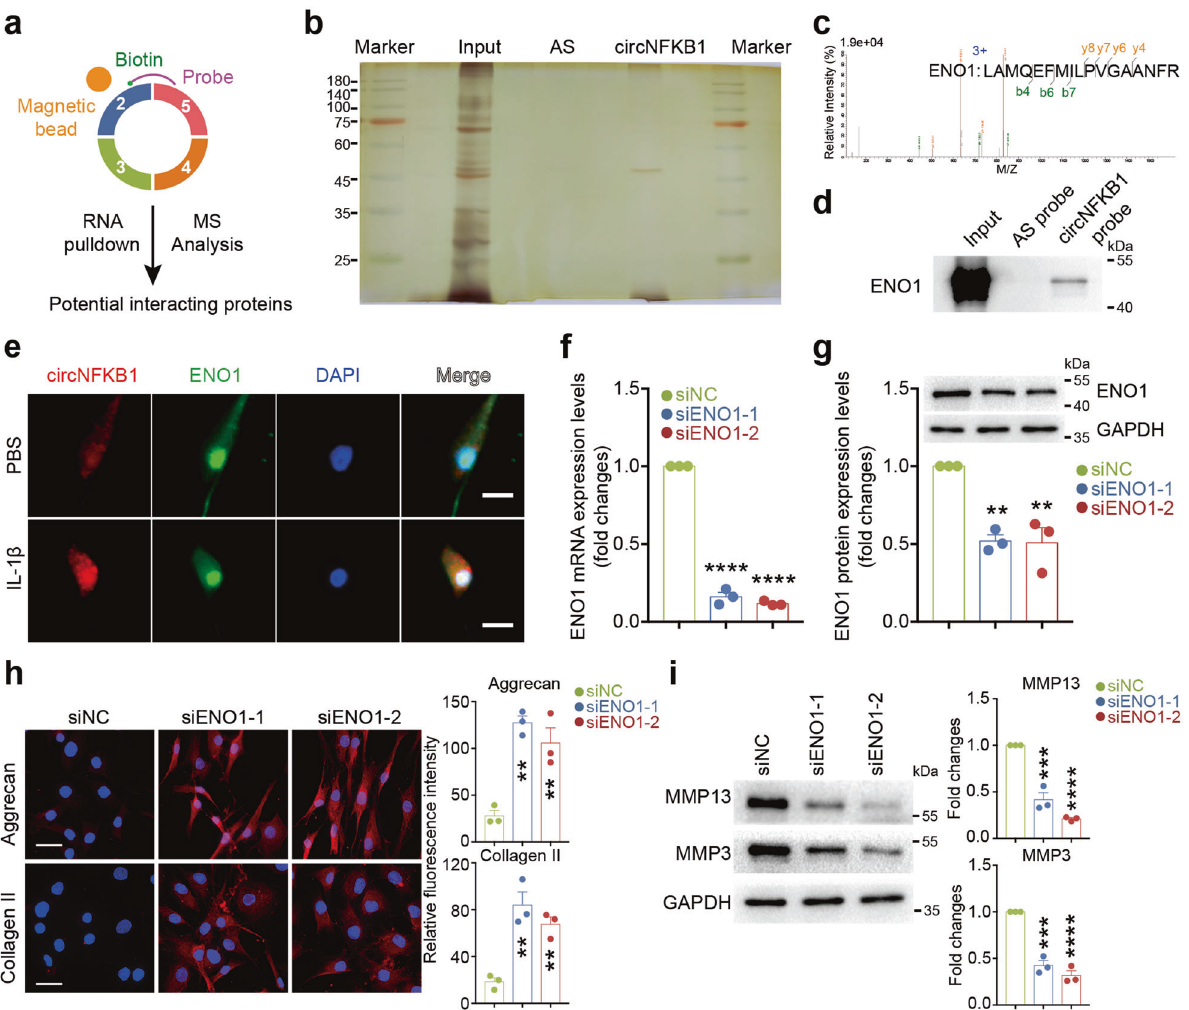
Fig. 6 circNFKB1 associates with ENO1 in human chondrocyte nuclei and silencing ENO1 inhibits IL-1 β -induced ECM degradation. a Schematic illustration of circNFKB1-associated proteins detected by RNA pulldown and MS analysis in human chondrocytes. b Silver staining of RNA pulldown assay with circNFKB1 and control probes. AS antisense. c Mass spectrometry analysis of circNFKB1-binding proteins after RNA pulldown assay. d Western blotting of the interaction between ENO1 circNFKB1 after RNA pulldown. e Confocal images showing the colocalization of circNFKB1 and ENO1 in chondrocytes treated with PBS or IL-1 β . DAPI, 4 ′ ,6-diamidino-2-phenylindole. Scale bar, 10 μ m. f qRT- PCR analysis showing ENO1 mRNA levels after ENO1 knockdown with siRNAs in HCs. g Western blotting analysis showing ENO1 protein levels after ENO1 knockdown. h Representative immuno fl uorescence images of Aggrecan and Collagen II protein levels in chondrocytes after ENO1 knockdown. Scale bars, 25 μ m. i Western blotting analysis of MMP3 and MMP13 expression in ENO1 knockdown chondrocytes. f – i , mean values ± SD are shown, and p values were calculated by two-tailed one-way ANOVA followed by Sidak ’ s multiple comparison test. ** p < 0.01, *** p < 0.001, **** p < 0.0001, ns, not signi fi cant. b , d , e , and h , representative images are